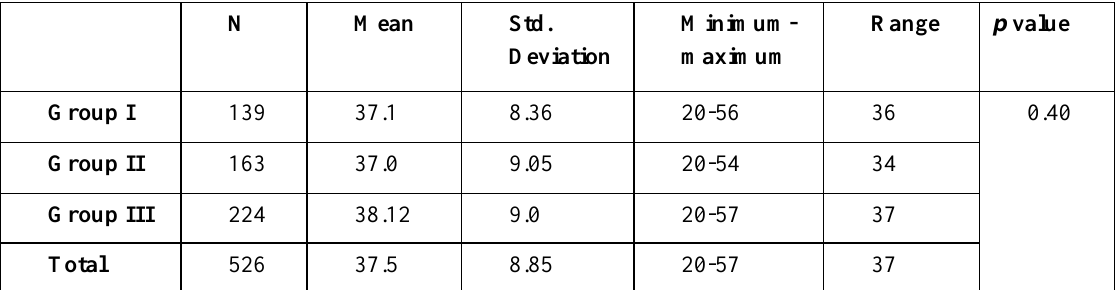
Table 1. Age distribution among studied groups.